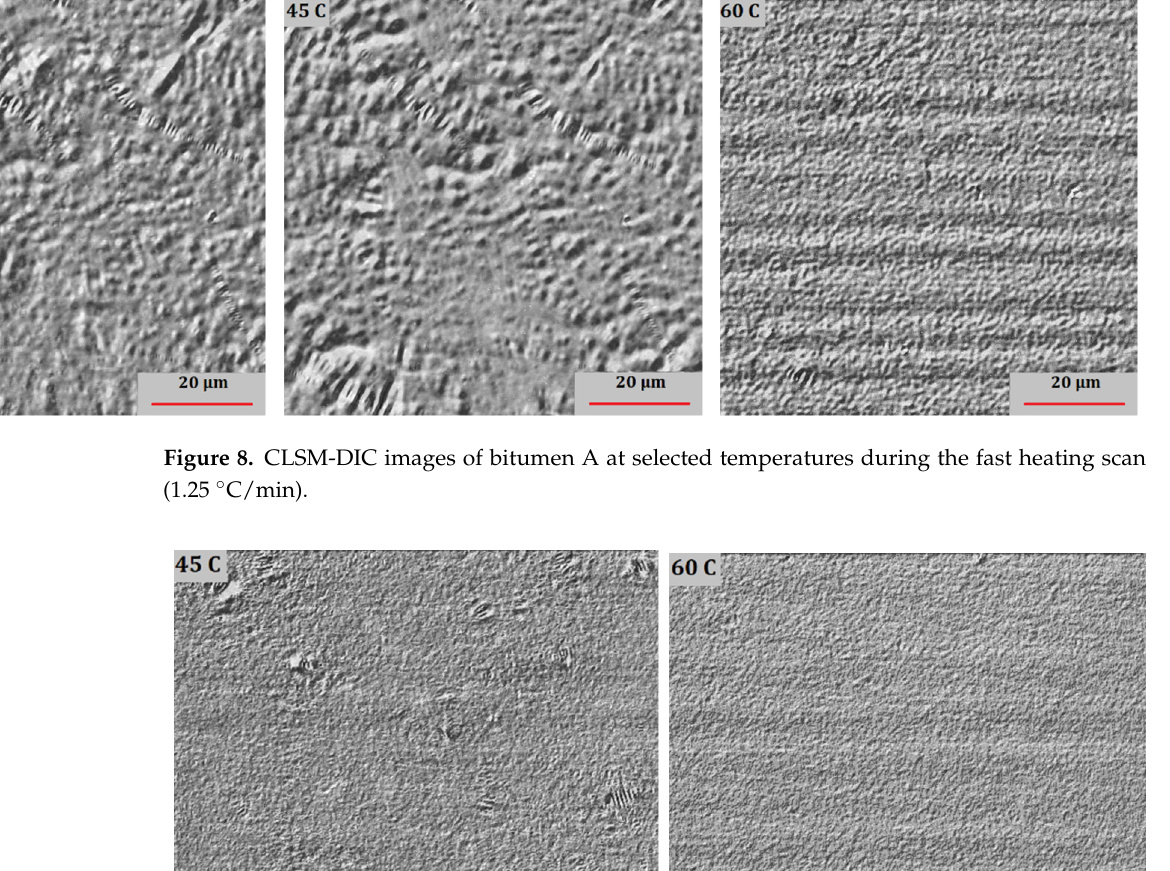
Figure 8. CLSM-DIC images of bitumen A at selected temperatures during the fast heating scan (1.25 °C/min).